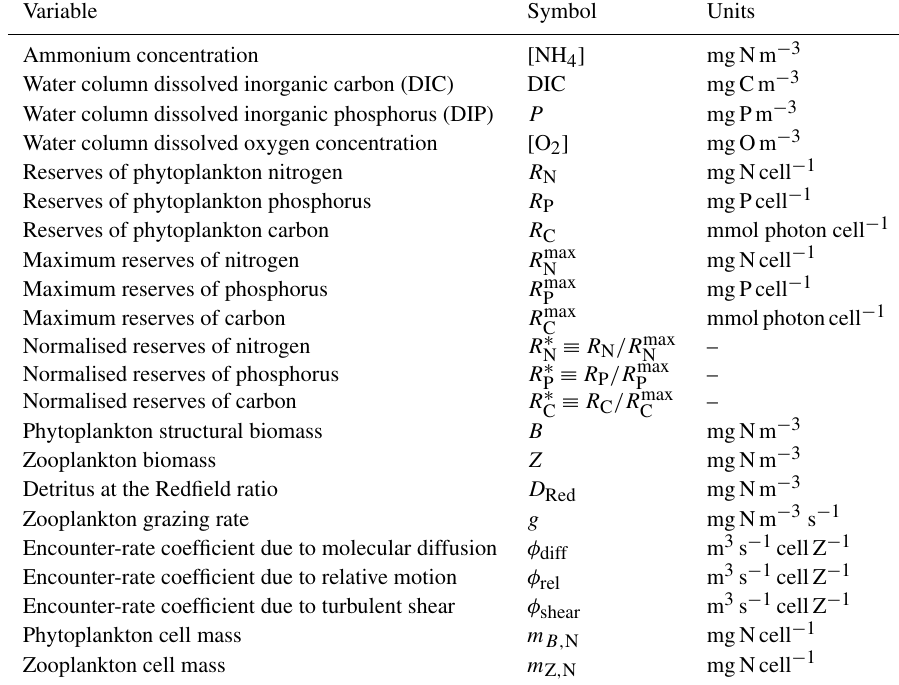
Table 11. State and derived variables for the zooplankton grazing. Zooplankton cell mass, m Z = 16000 × 14 . 01 × 10 . 5 V Z mgNcell − 1 , where V Z is the volume of zooplankton (Hansen et al.,